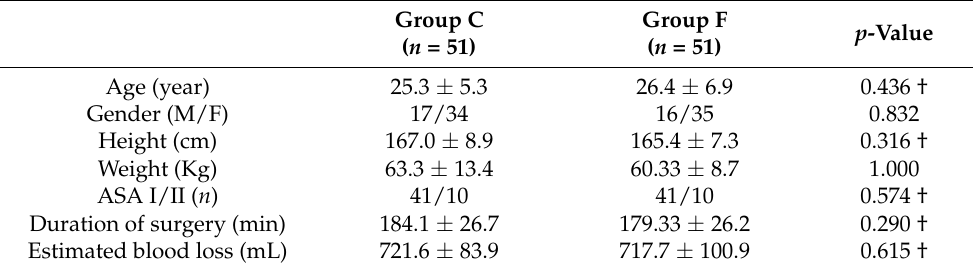
Table 1. Demographic features of participants and duration of surgery.